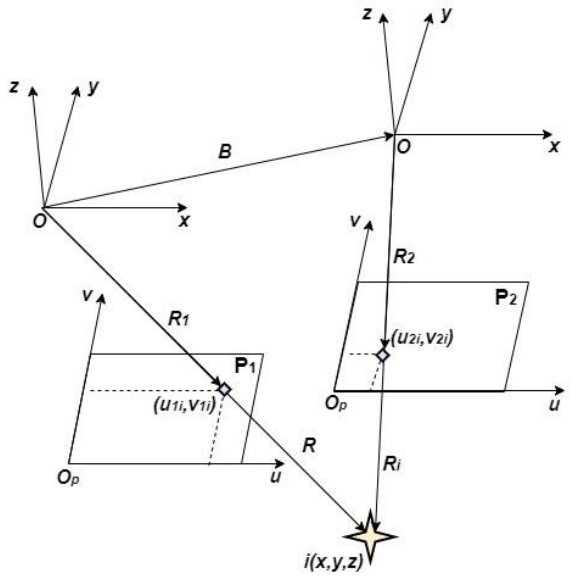
Figure 1 . Triangulation